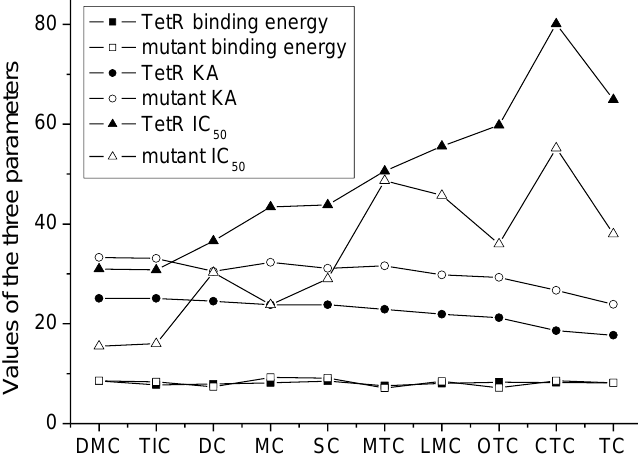
Figure 6. Change trends of the binding energy, absolute affinity constant (KA), and IC 50 for the 10 TCs when using the natural TetR and the mutant.